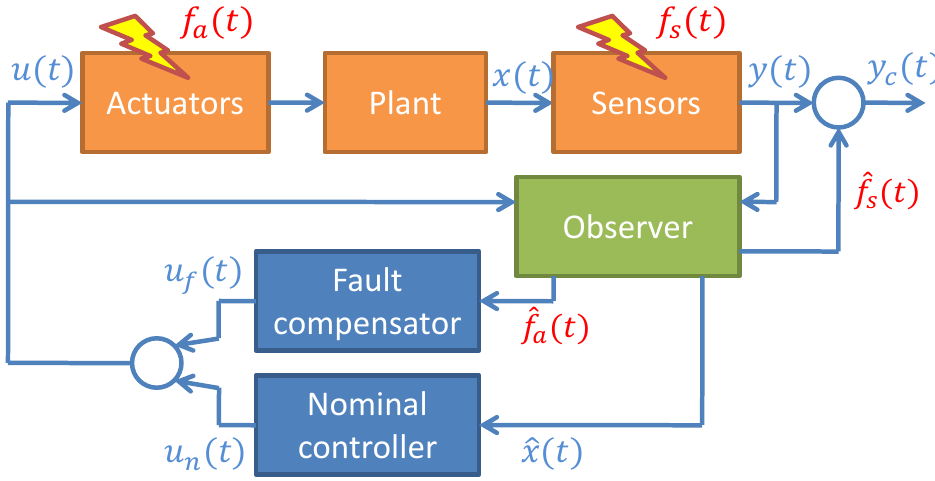
Figure 9. Controller reconfiguration FTC